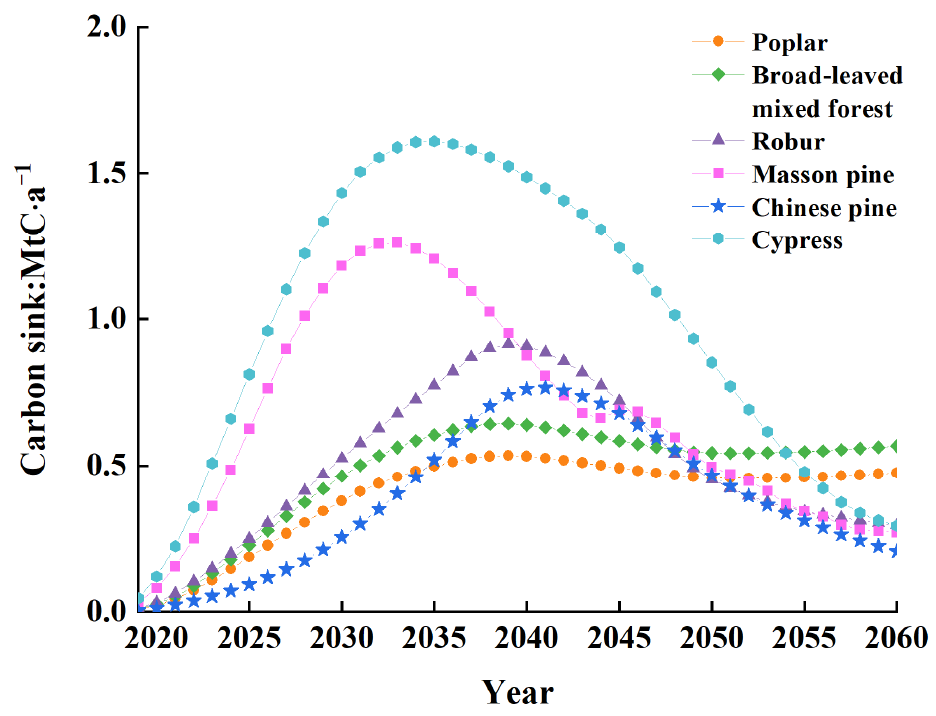
Figure 6. Carbon sinks of dominant tree species for new afforestation, 2019–2060.